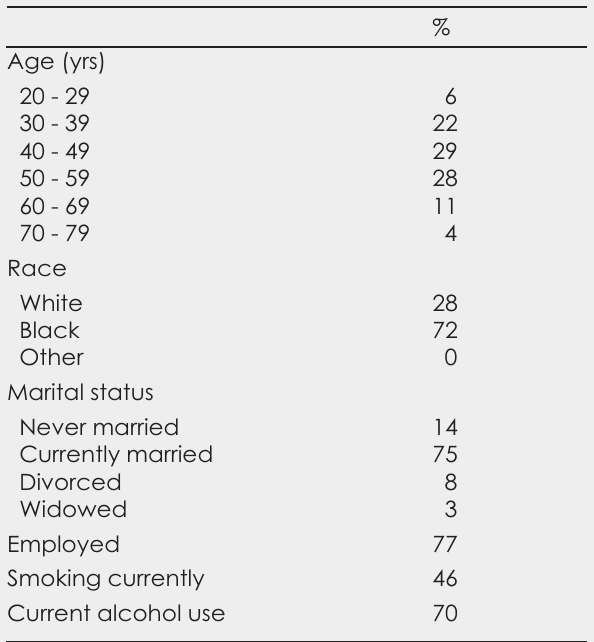
Table I. Characteristics of respondents ( N =